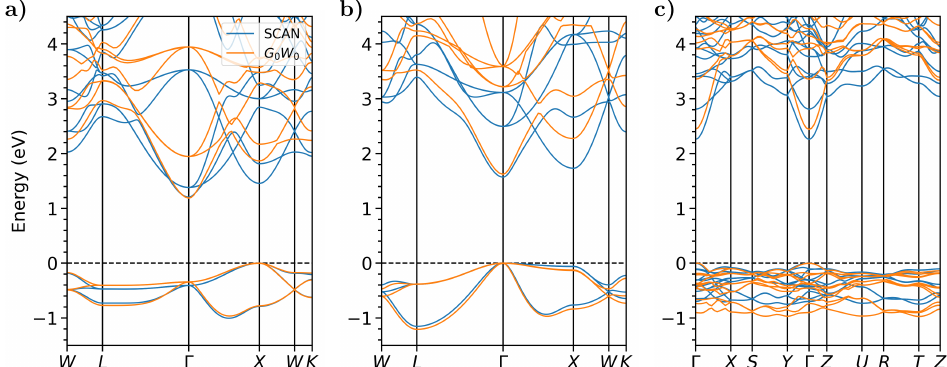
Figure 3. Electronic band structures of ( a ) Cs 3 Sb, ( b ) CsK 2 Sb, and ( c ) Cs 2 Te calculated from DFT with the SCAN functional (blue) as well as from G 0 W 0 on top of PBE (orange). The zero of the plots is set to the top of the valence band of both calculations. The data for the SCAN band structures of Cs 3 Sb and Cs 2 Te coincide with those published in Reference [70]. Table 1. Electronic and optical band gaps of the materials calculated with different computational methods, including a comparison to experimental references. All values in eV. PBE SCAN SCAN + SOC G 0 W 0 @PBE BSE Exp. Cs 3 Sb E gap